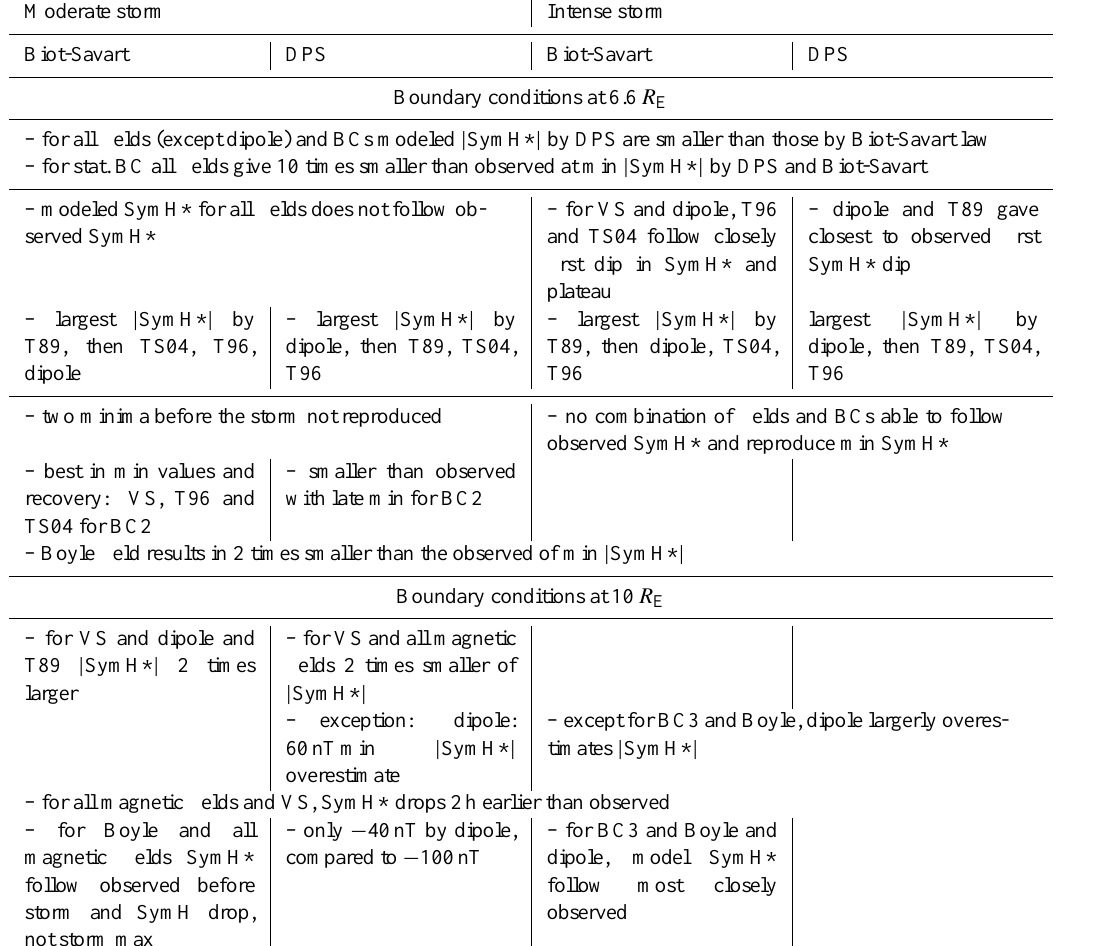
Table 3. Model-dependent storm-time ring current: modeled SymH* index. Moderate